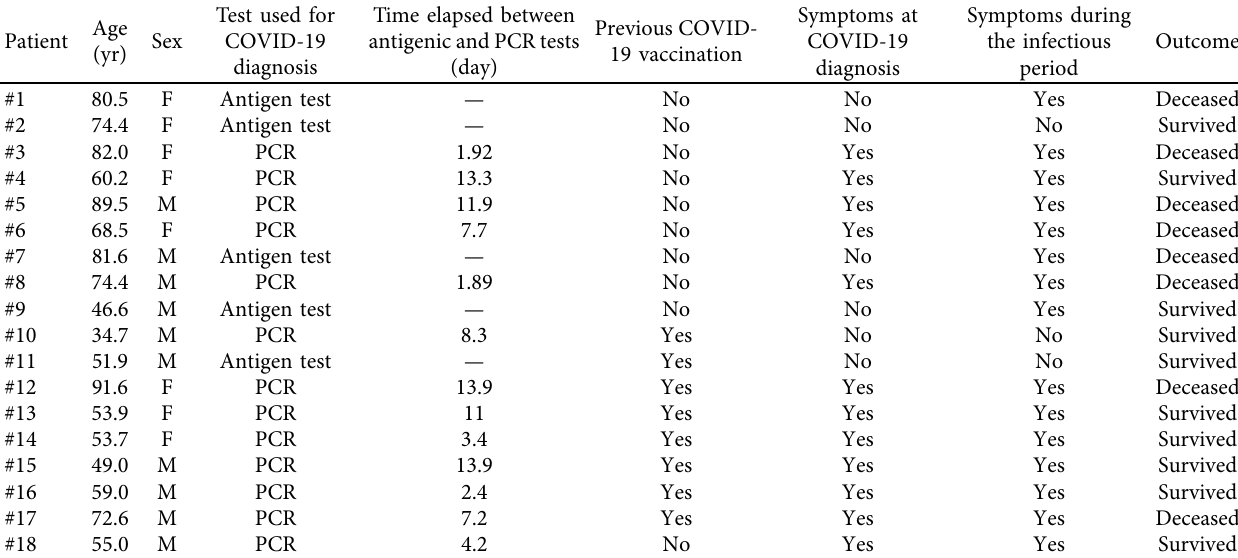
Figure 1: Flowchart of rapid antigen screening in patients on in-center hemodialysis. Table 1: Demographic and clinical characteristics of all hemodialysis patients who contracted